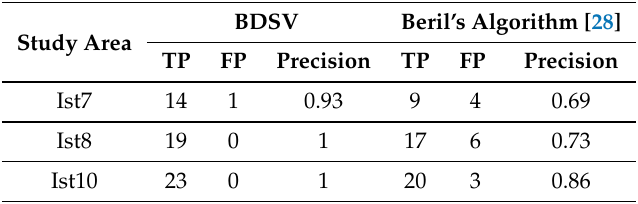
Table 10. Precision comparison of BDSV and Beril’s algorithm [28].